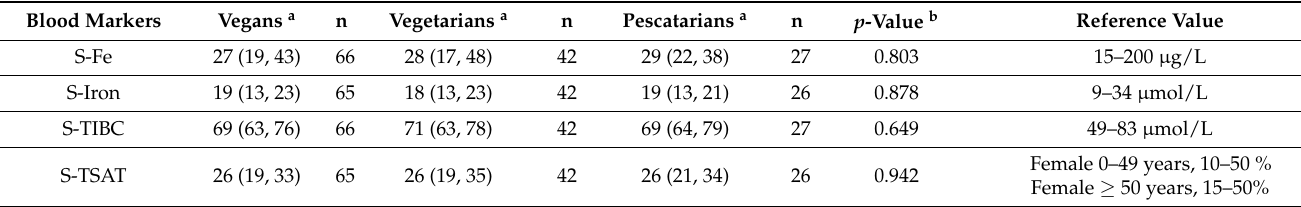
Table 3. Concentrations of measured non-fasting blood markers for iron status in male vegans ( n = 40), vegetarians ( n = 12) and pescatarians ( n = 4).